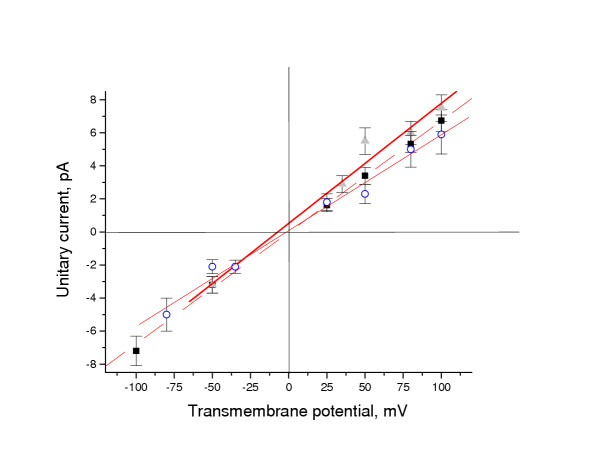
The unitary current/voltage (I-V) relationship of channels formed by protein of each enrichment step. The I-V relationships were obtained using L-Arg – active protein from the RCA-I lectin column (o) from the first peak fractions off the Sephacryl S-300 HR column (■) and from the pH 9 elution of the ion-exchange column (▲). Measurements were made under symmetrical conditions of 100 mM NaCl, 1 mM CaCl2 and 5 mM MOPS (pH = 7.2). Data points indicate the Mean ± S.D. The data sets are well fit by a linear regression (r = 0.99 solid and dotted lines) with slopes of 58, 67, and 73 pS respectively. Bilayer was DOPS:DOPE, 1:1.